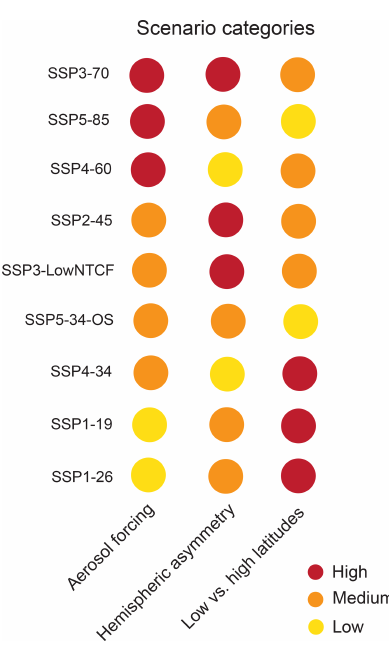
Figure 10. Categories in the MACv2-SP interpretation of the CMIP6 anthropogenic aerosol scenarios. Shown is the colour-coded ranking of the CMIP6 scenarios with respect to the strength of the aerosol forcing, the hemispheric asymmetry, and the low- to high- latitude difference in the